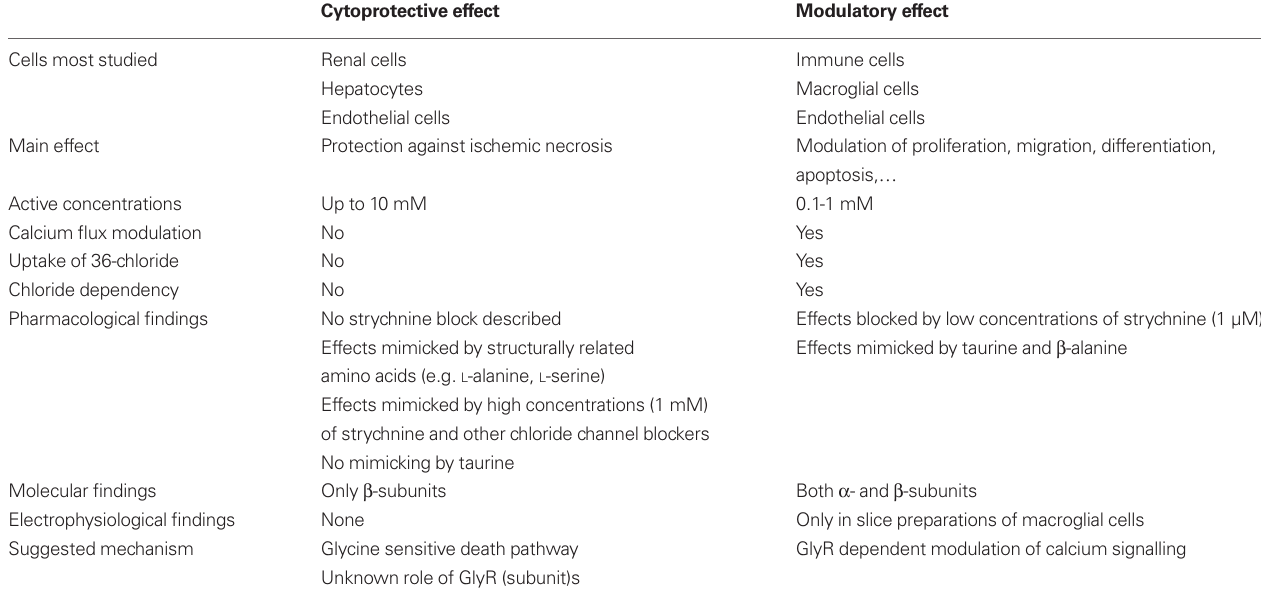
Table 1 | Most often evoked mechanisms responsible for glycine effects in non-neuronal